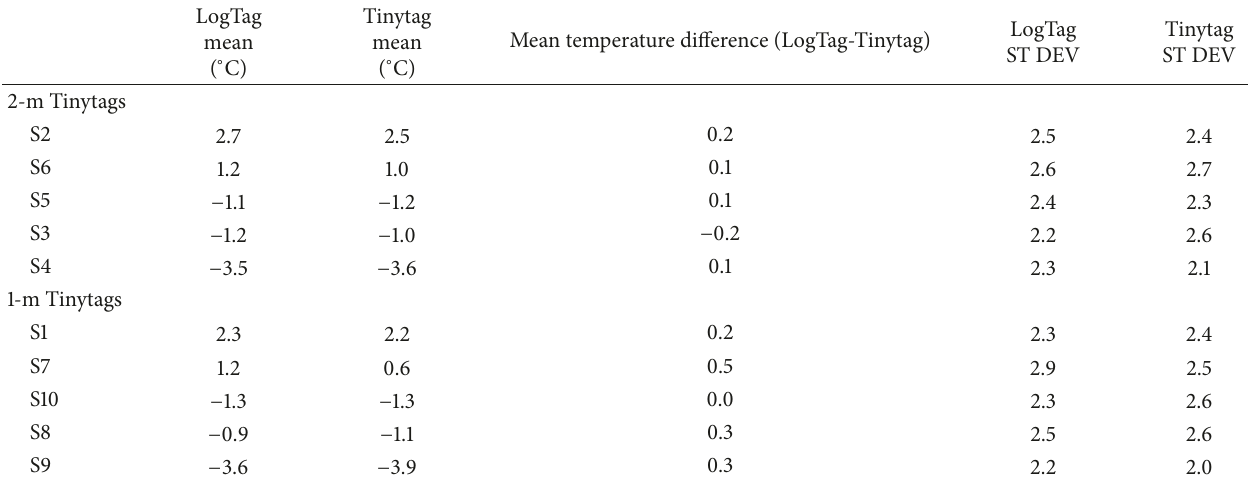
Table 8: A comparison of mean temperatures and the spread of temperature values (standard deviation: ST DEV) ( ∘ C) recorded by LogTag and Tinytag instruments, based on 2-min data for 22–26 March,